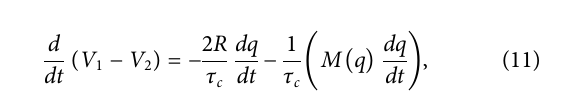
FIGURE 7 | System evolution using two different initial charges q 0 (cid:1) 1 V for Cond-2 (dash curves). (A) Memristance transition showing the variation effect of the initial charge; (B) the corresponding evolution of V V 2 0